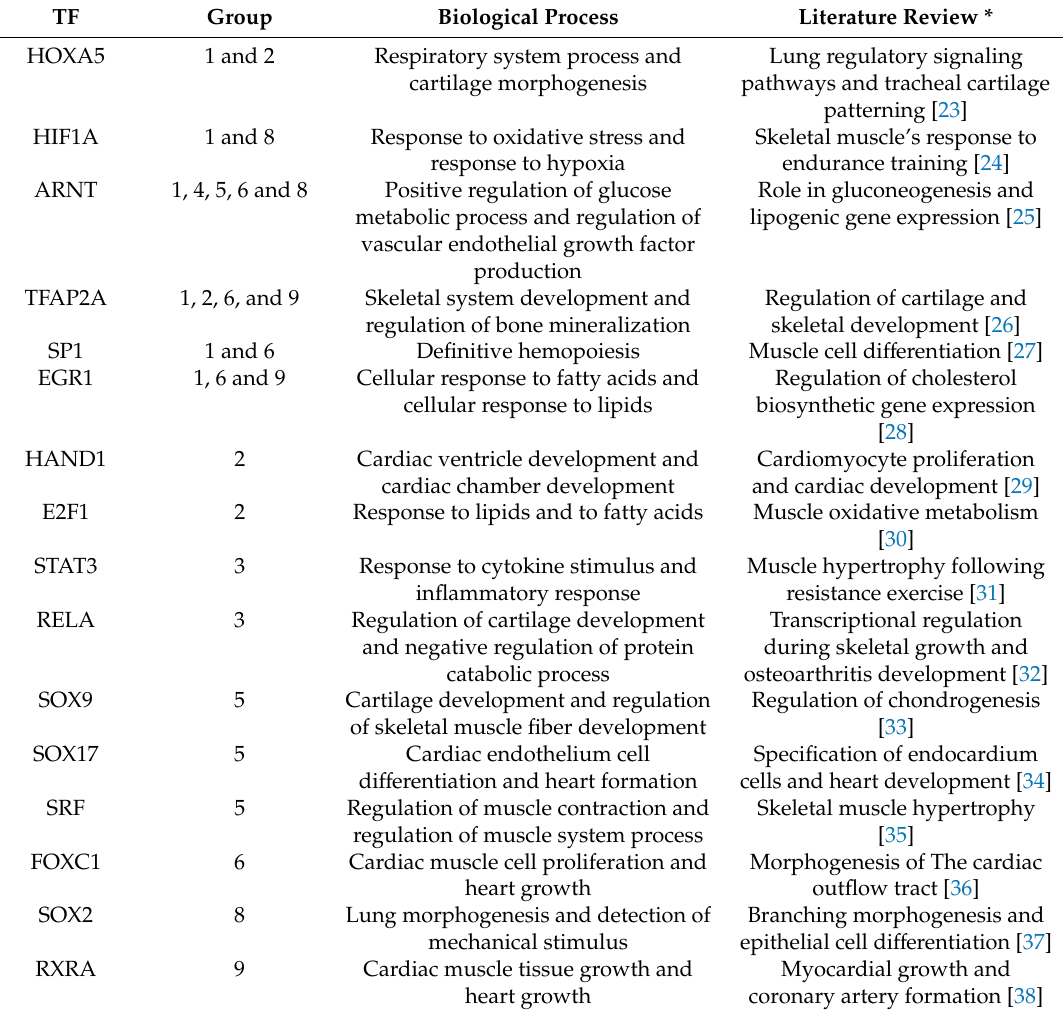
Table 2. Main Transcription factors (TFs). Most representative TFs, associated with genes identified for each group, based on their biological processes and The literature